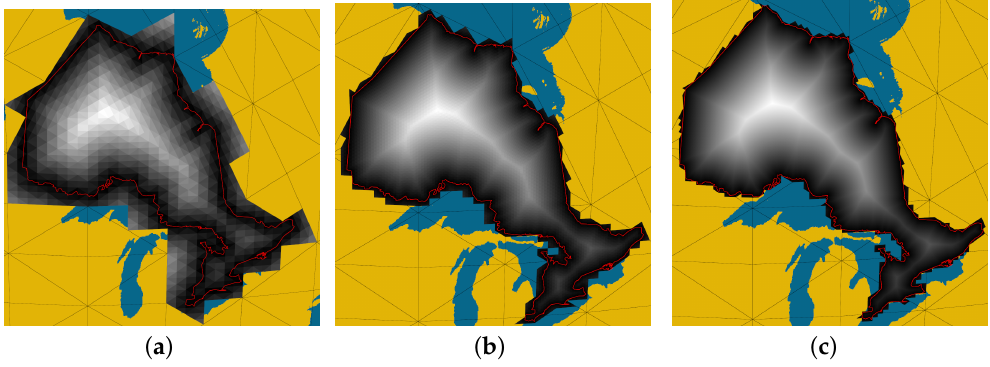
Figure 12. Distance transform for the border of Ontario at target resolution ( a ) 7 (Avg. cell size: